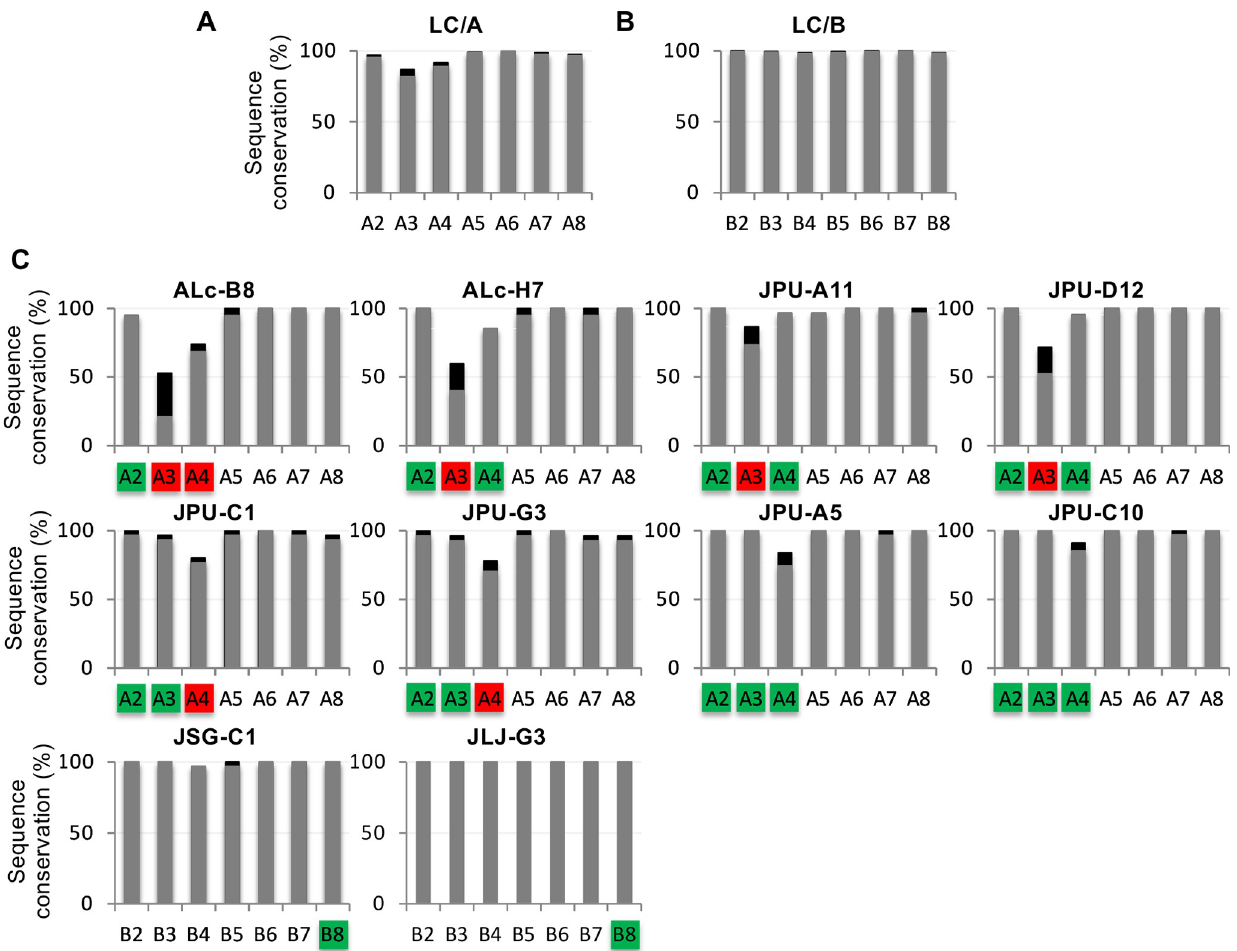
Fig 7. Sequence conservation of VHH-binding epitopes on LC across BoNT/A or BoNT/B subtypes. (A, B) The overall amino acid sequence identity (grey) and similarity (black) among BoNT/A or BoNT/B subtypes using A1 and B1 as the benchmarks. (C) The conservation of epitope sequences for selected LC/A- and LC/B-binding VHHs are shown. Green labels indicate comparable VHH binding to that specific subtype in comparison to A1 or B1, while red indicating weakened binding.